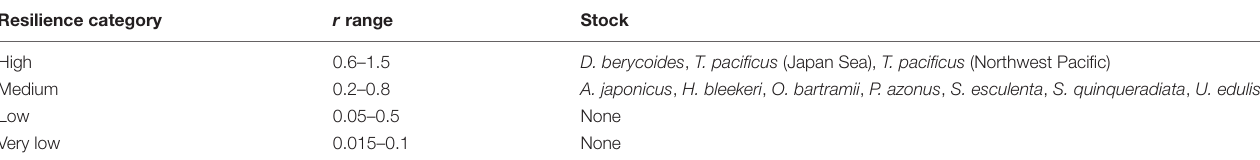
FIGURE 2 | Viable r-k pairs of spear squid ( Heterololigo bleekeri ) (Japan Sea) (A) and Japanese sandfish (Arctoscopus japonicus ) (Japan Sea) (B) obtained from the CMSY (gray) and the BSM (black) methods. The most reliable r-k pair and its approximate 95% confidence limits are indicated by a black cross for the CMSY method (A,B) ; for the BSM method, the corresponding cross is gray (B) . TABLE 2 | Suggested resilience categories translated into range of rate of population increase ( r ) as provided in FishBase and SeaLifeBase of stocks under assessment (www.fishbase.org, www.sealifebase.org and Froese et al., 2017).